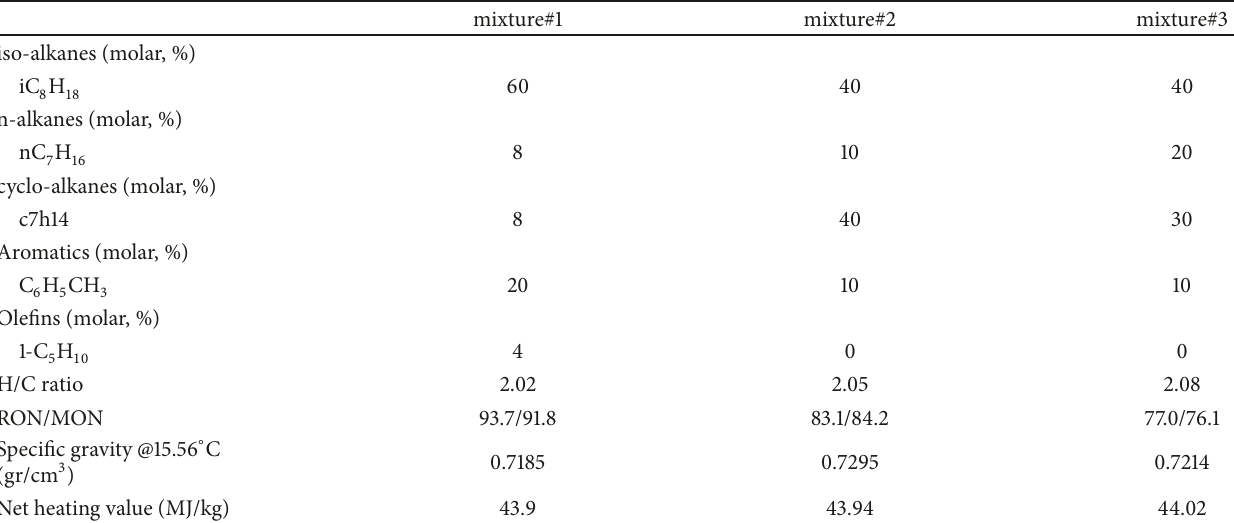
Table 11: Composition and properties of Naik et al. [33] surrogates.